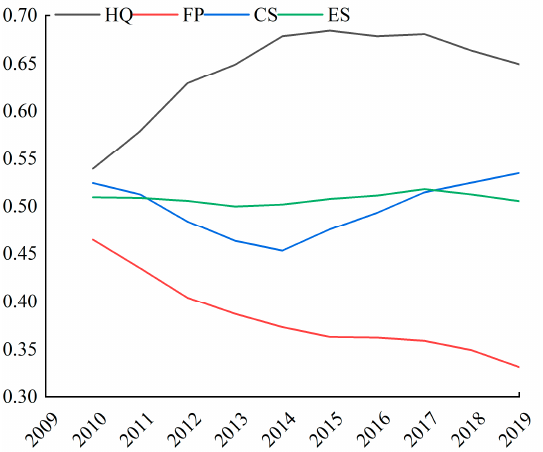
Figure 4. Change trend of subdimensions of ES in 2010–2019.